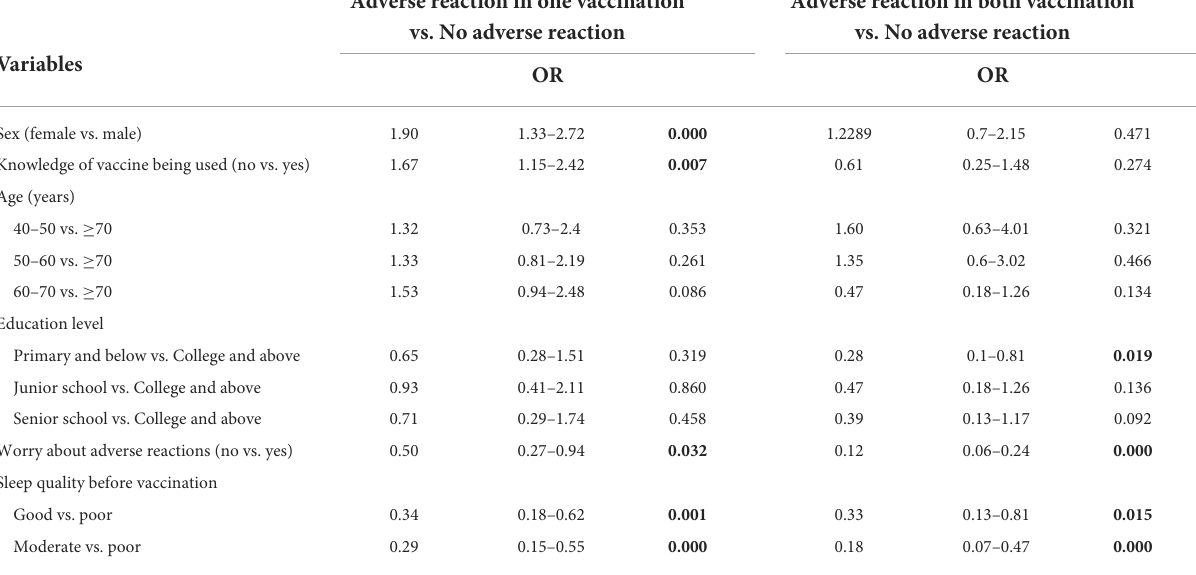
TABLE 5 Multinominal logistic regression of factors associated with adverse reactions in completed two doses vaccinated group ( n = 1,410).